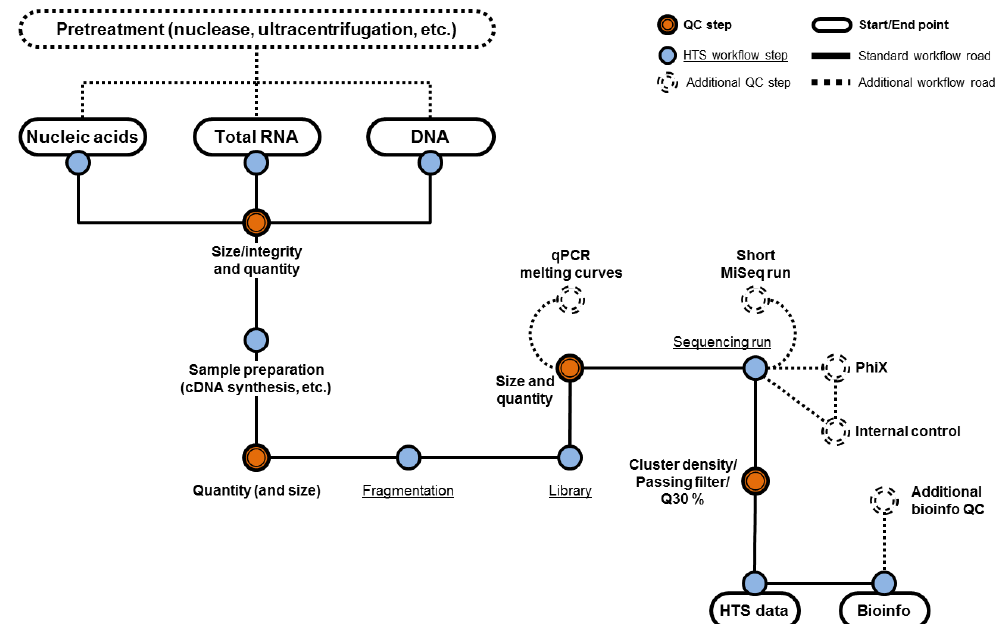
Figure 1. Different approaches for high-throughput sequencing (HTS) sample preparation and potential quality control (QC) opportunities. Experimental steps and potential QC steps are represented by blue and orange circles respectively. The minimum steps for the detection of adventitious viruses are connected by solid lines with optional QC procedures connected by dashes. Figure 1 starts with potential pre-treatment of the sample prior to nucleic acid extraction (e.g., total nucleic acid, total RNA or total DNA extractions). The extracted material is assessed for size, integrity, and quality to ensure sufficient amount of input material. After sample preparation the integrity of DNA and the quality of the library is again assessed. At this point, the quality of the sequencing library can be confirmed by doing qPCR or a small scale sequencing run (e.g., MiSeq) prior to a full-scale sequencing run to save cost and time. Additionally, internal controls can be included into the sample as a way to monitor the performance of the sample preparation and sequencing.